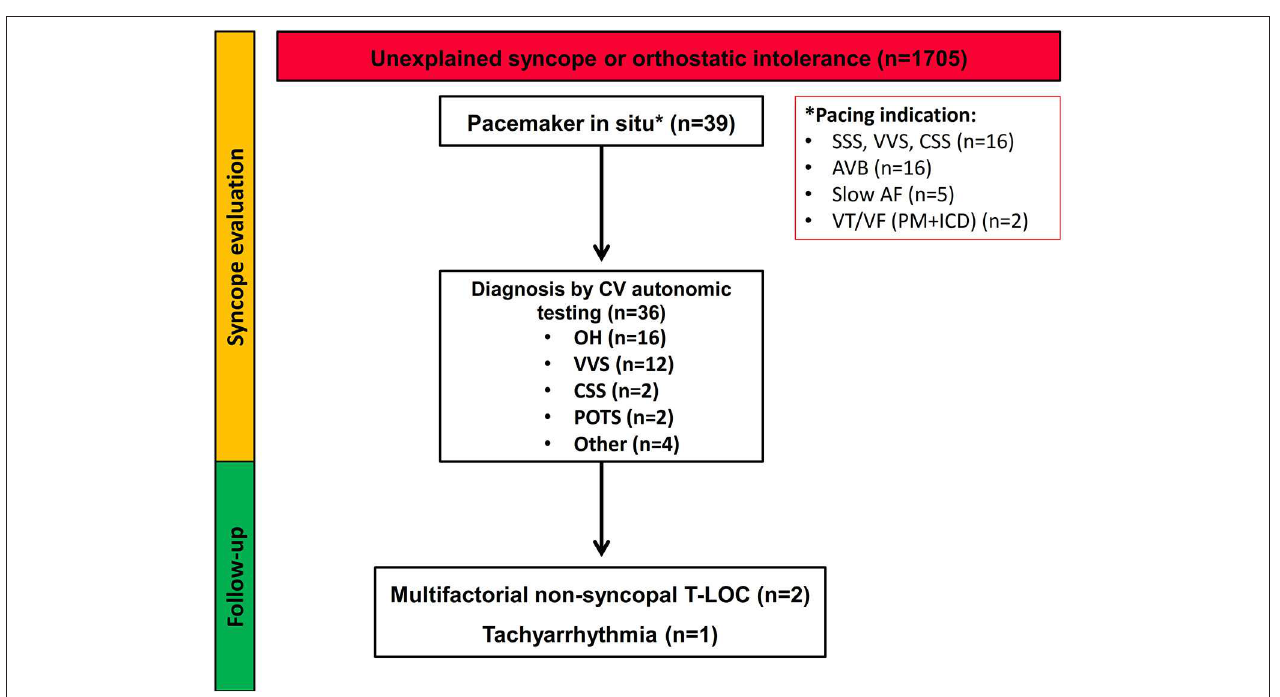
FIGURE 1 | Flow-chart of the study population. The diagram summarizes the diagnostic work-up and follow-up of patients presenting with unexplained syncope or symptoms of orthostatic intolerance. SSS, sick sinus syndrome; VVS, vasovagal syncope; CSS, carotid sinus syndrome; POTS, postural orthostatic tachycardia syndrome; AVB, atrioventricular block; AF, atrial fibrillation; VT, ventricular tachycardia; VF, ventricular fibrillation; PM, pacemaker; ICD, implantable cardioverter defibrillator; T-LOC, transient loss of